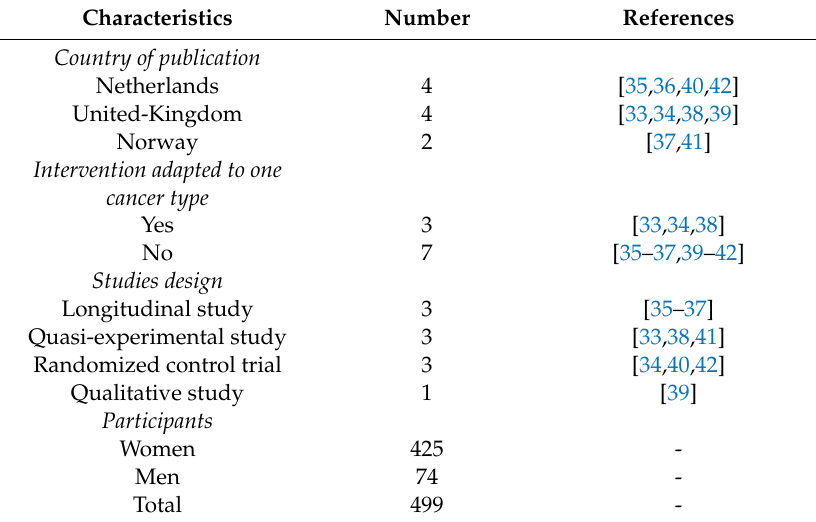
Table 1. Characteristics of the included